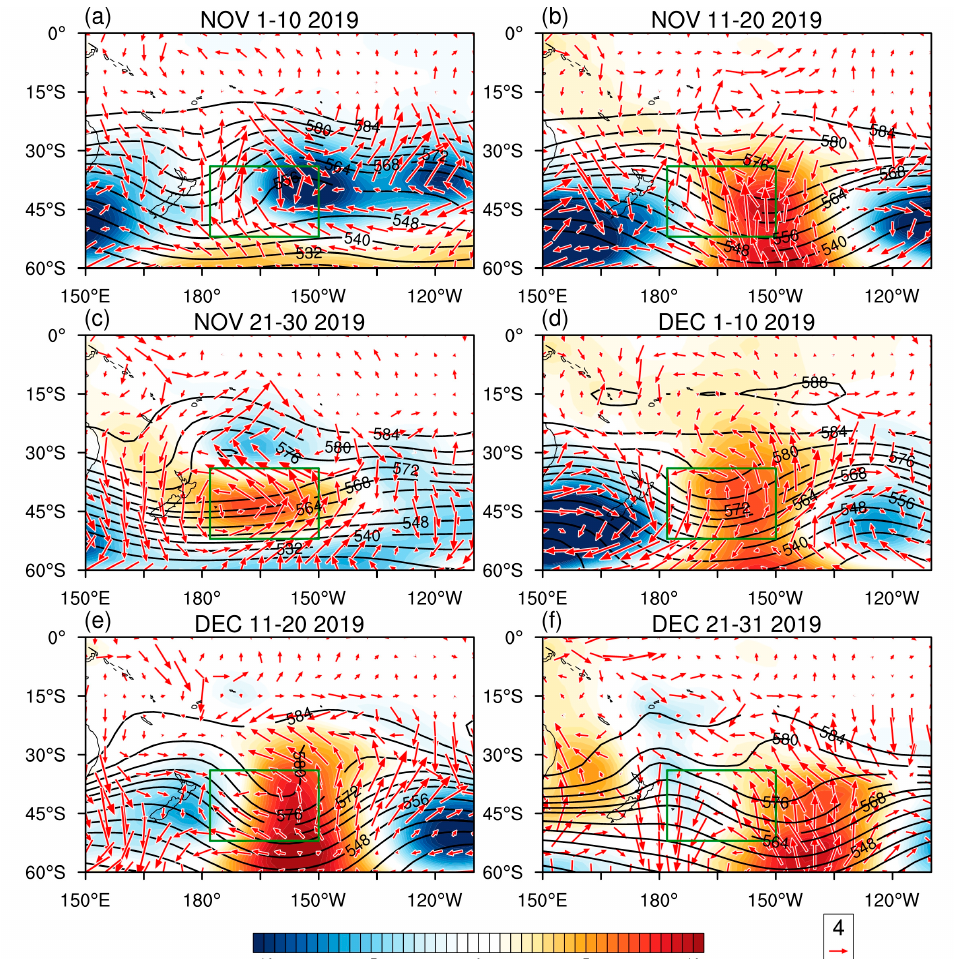
Figure 3. Sea level pressure (SLP) anomalies (shading, in hPa), surface wind anomalies (vector, in m / s), and total geopotential heights at 500 hPa (black contour, in dagpm) averaged over ( a ) 1–10 November, ( b ) 11–20 November, ( c ) 21–30 November, ( d ) 1–10 December, ( e ) 11–20 December and ( f ) 21–31 December of 2019. The green boxes denote the blob area.